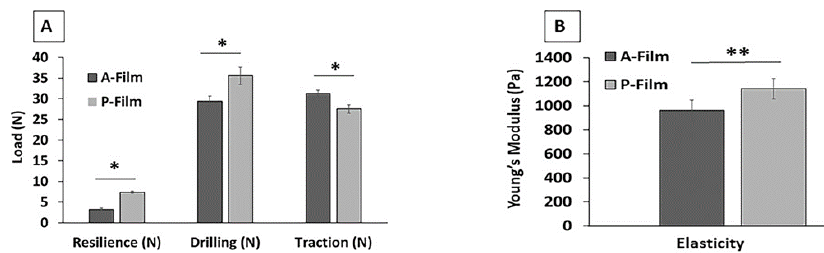
Figure 2. Physiomechanical properties as resilience, drilling, traction ( A ), and elasticity ( B ) of mucoadhesive films. * Means that statistical di ff erences were found between the P-film and A-film ( p < 0.05). ** Means that statistical equals were not found between the P-film and A-film ( p > 0.05). ( n = 3; bar charts represent standard deviation values).